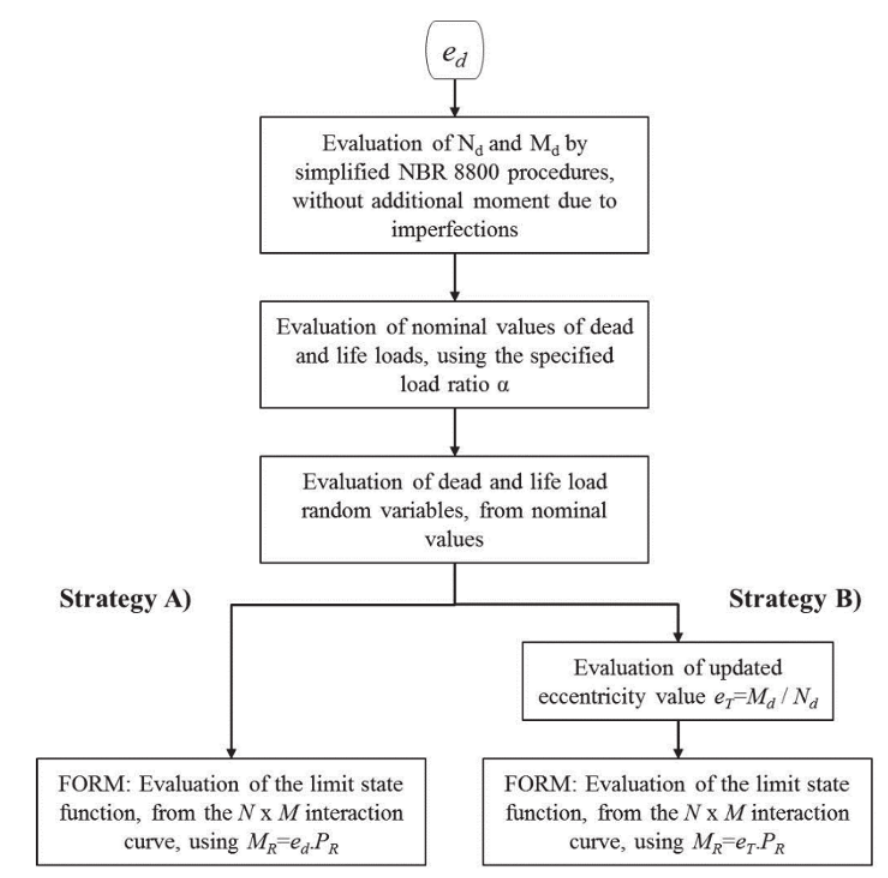
Fluxograms for analysis strategies: a) A and b)